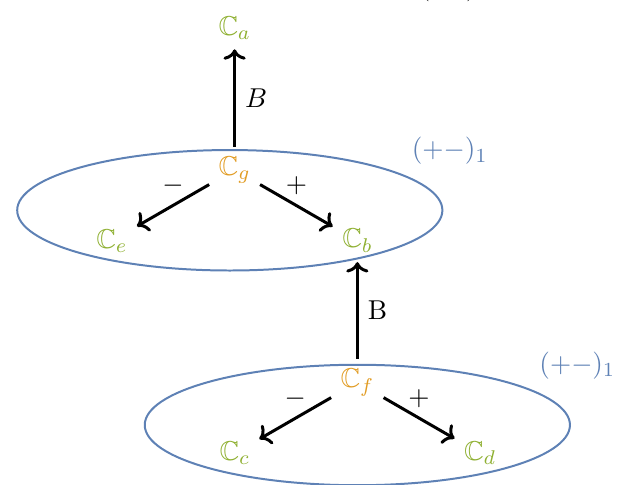
Figure 39. A di(cid:11)erent tree module for a dimension (2 ; 5) representation.